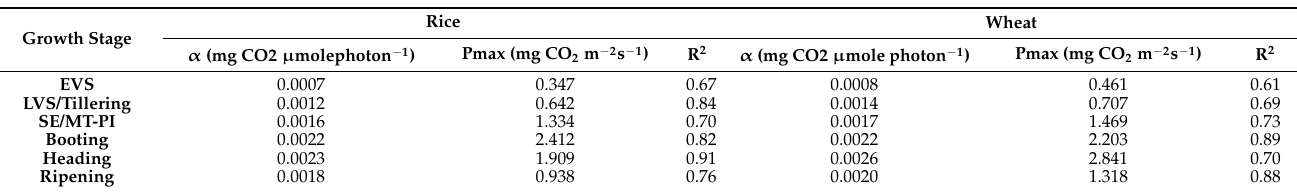
Table 3. Apparent ecosystem quantum yield ( α ), the hypothetical maximum of GPP (Pmax), at different growth stages in rice and